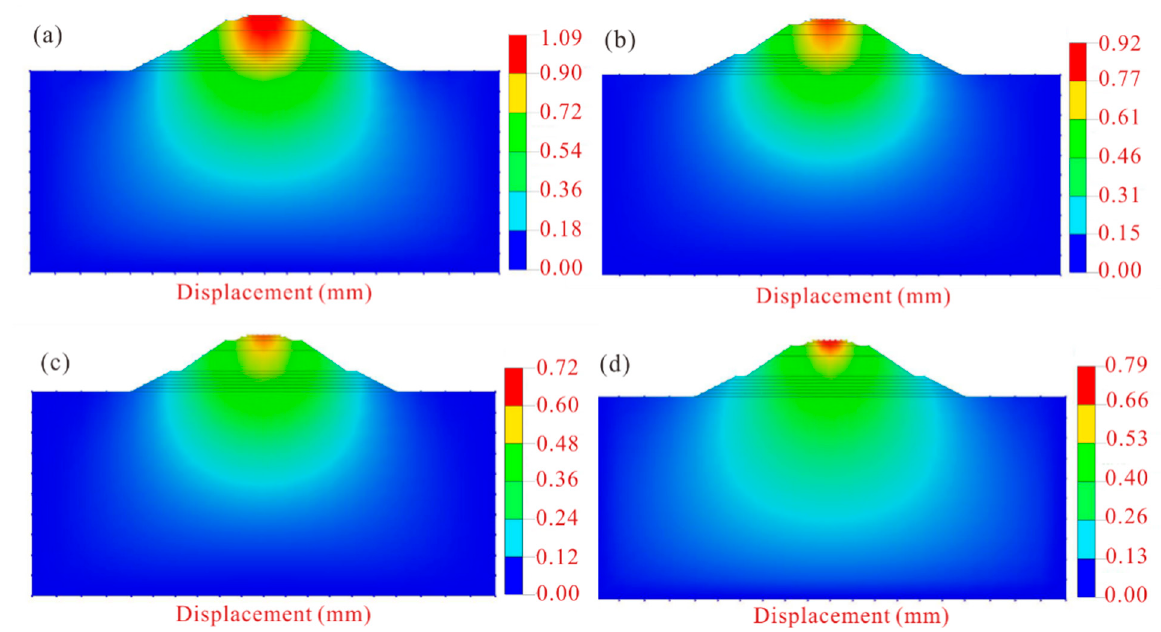
Figure 12. Settlement contour map of high-speed railway subgrade after improvement. ( a ) Scheme X; ( b ) scheme Y; ( c ) scheme Z; ( d ) scheme W.